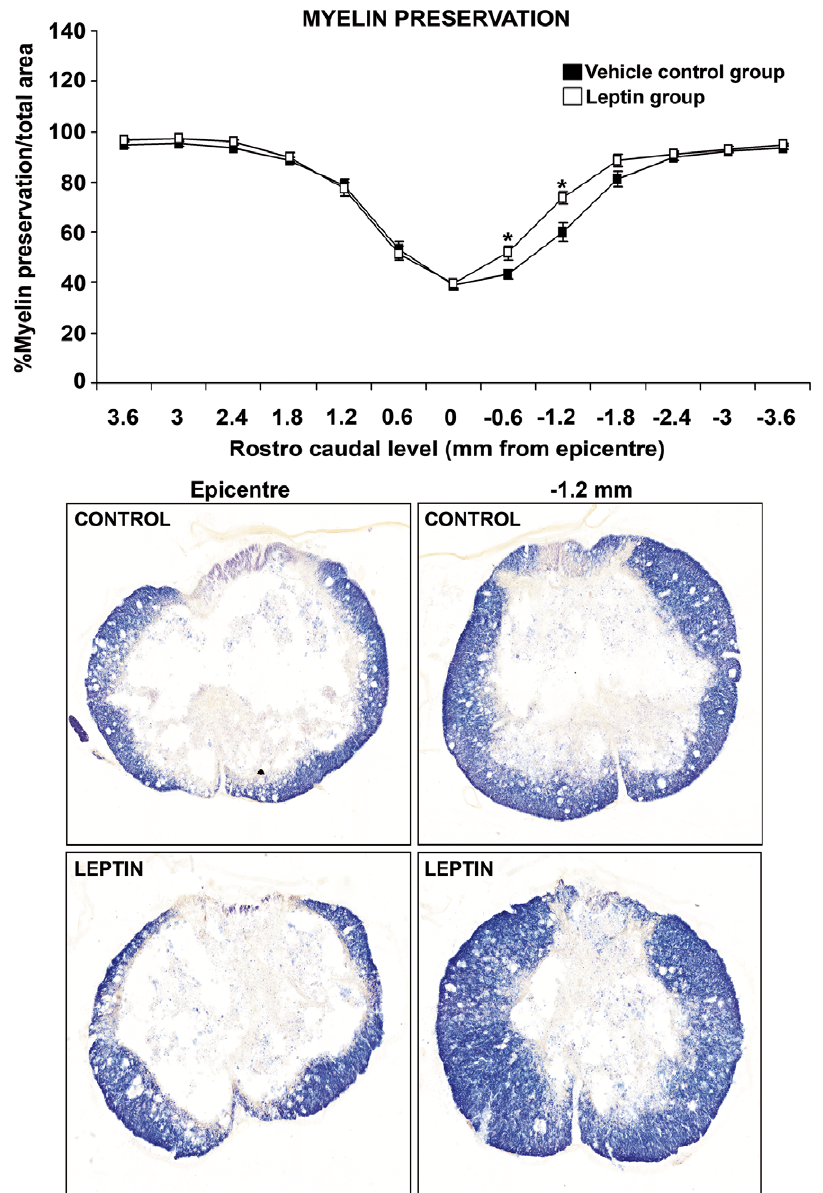
Figure 8. Leptin administration increases the preservation of caudal white matter. Leptin administration significantly increased the preservation of white matter when compared with vehicle treated controls, specifically in areas corresponding to caudal levels adjacent to the lesion epicentre. The values represent the mean 6 SEM; * p , 0.05 versus the vehicle-treated controls.